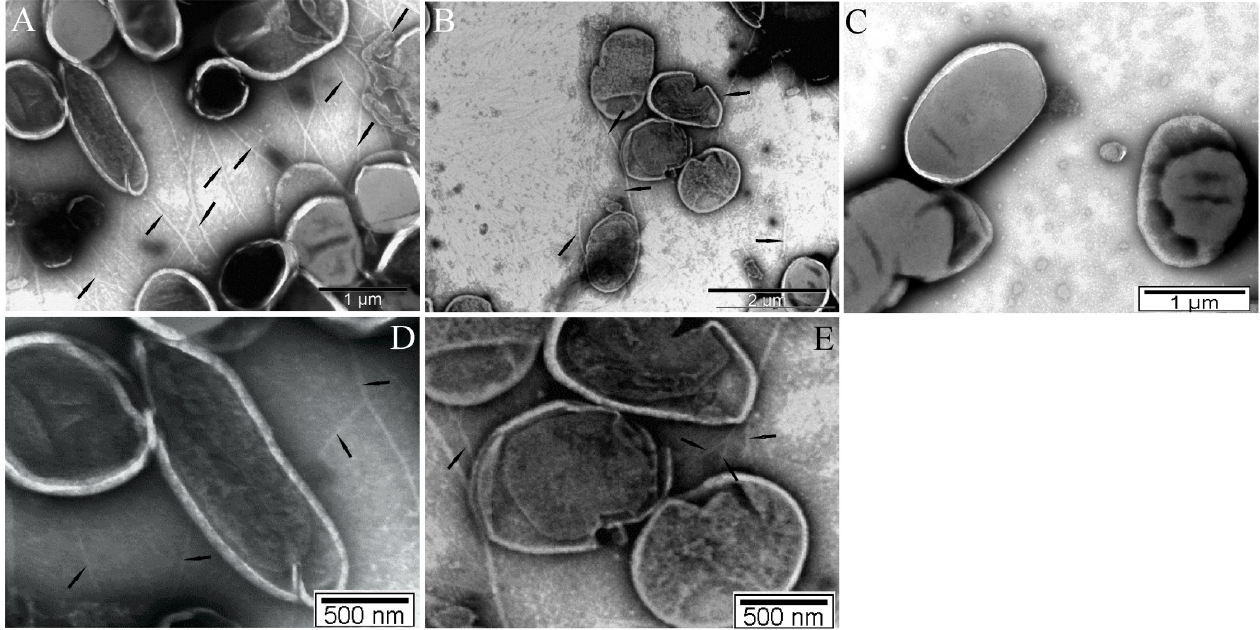
Fig 1. Pili expression on the surface of F . novicida . Shown are electron micrographs of wt F . novicida bacteria (A and D) , the complemented strain pilO/O (B and E) and the pilO mutant strain (C) . On panels A and B, black arrows indicate thick pili structures, while the arrows on panels D and E indicate the thin pili structures. Bacteria were grown at 30˚C, stained with PTA and examined by transmission electron microscopy. Pili were observed in three independent experiments, with hundreds of bacteria being examined within each experiment.